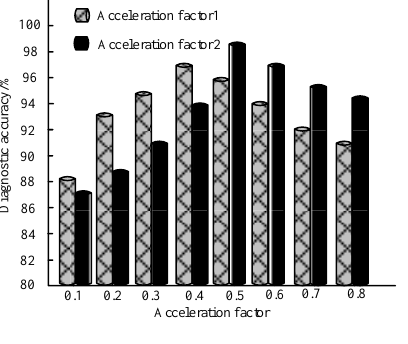
Figure 6. Influence of different acceleration factors on diagnostic accuracy